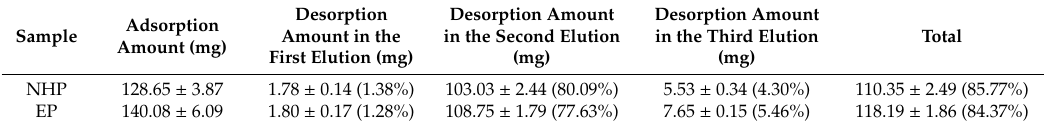
Table 5. Desorption of EGCG from the pretreated pomelo peel by three-stage elution